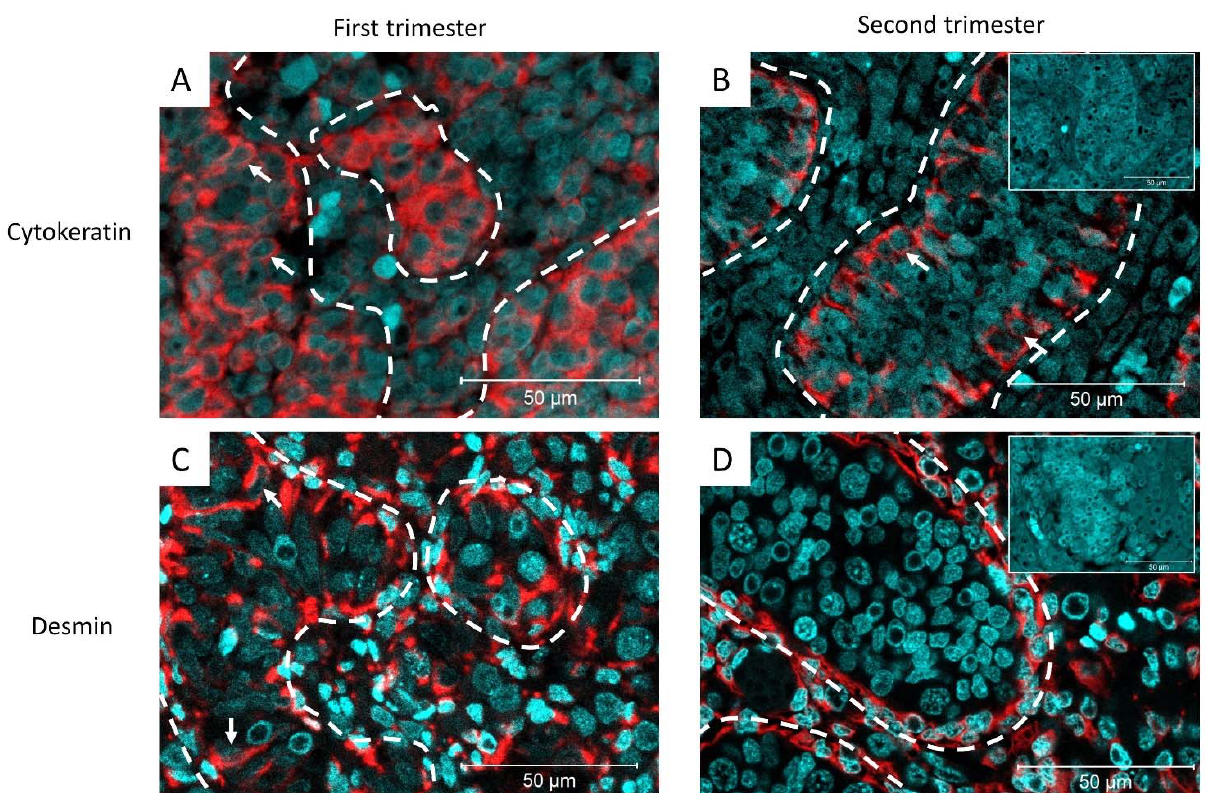
Figure 1. Representative images of cytokeratin expression in ( A ) first trimester (11 ‐ gestational week [GW]) and ( B ) second trimester (18 ‐ GW) of human fetal testis development. White arrows: cytokeratin+ Sertoli cells, inset: negative control (n = 8). ( C ) Desmin expression in the first trimester (10 ‐ GW) and ( D ) second trimester (17 ‐ GW) of human fetal testis development. White arrows: desmin + Sertoli cells. Dashed lines represent the periphery of the seminiferous tubule. Inset: negative control (n = 22).